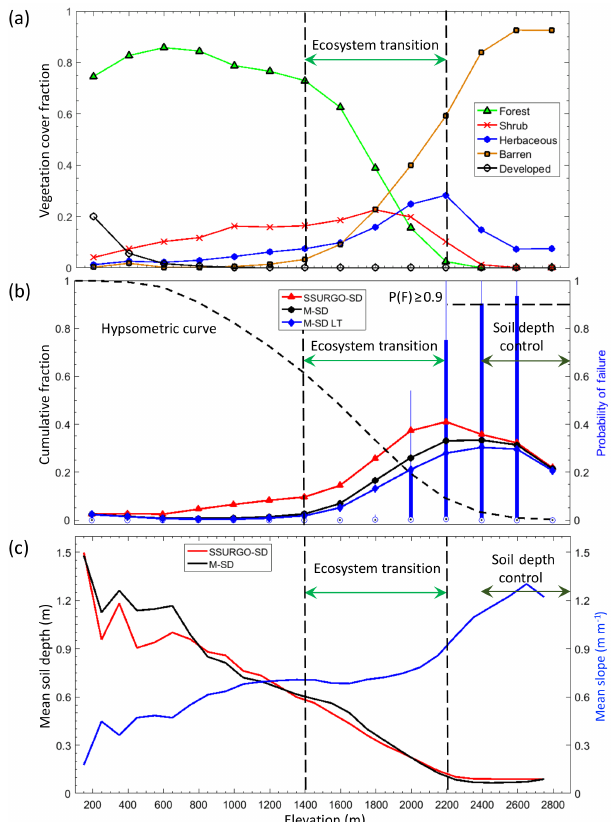
Figure 13. Elevation (200m bands or bin) influence on (a) vege- tation cover fraction for NOCA, taken as the fraction of vegetation type within each elevation band, (b) mean P ( F ) using SSURGO- SD and two M-SD scenarios, along with compact box–whisker plots for P ( F ) of the M-SD LT scenario (circle–dot symbols rep- resent median; outliers not shown) and overlaid with hypsometric curve for NOCA, and (c) mean soil depth for SSURGO-SD and M- SD products with mean slope. Mean values calculated within each 200m elevation